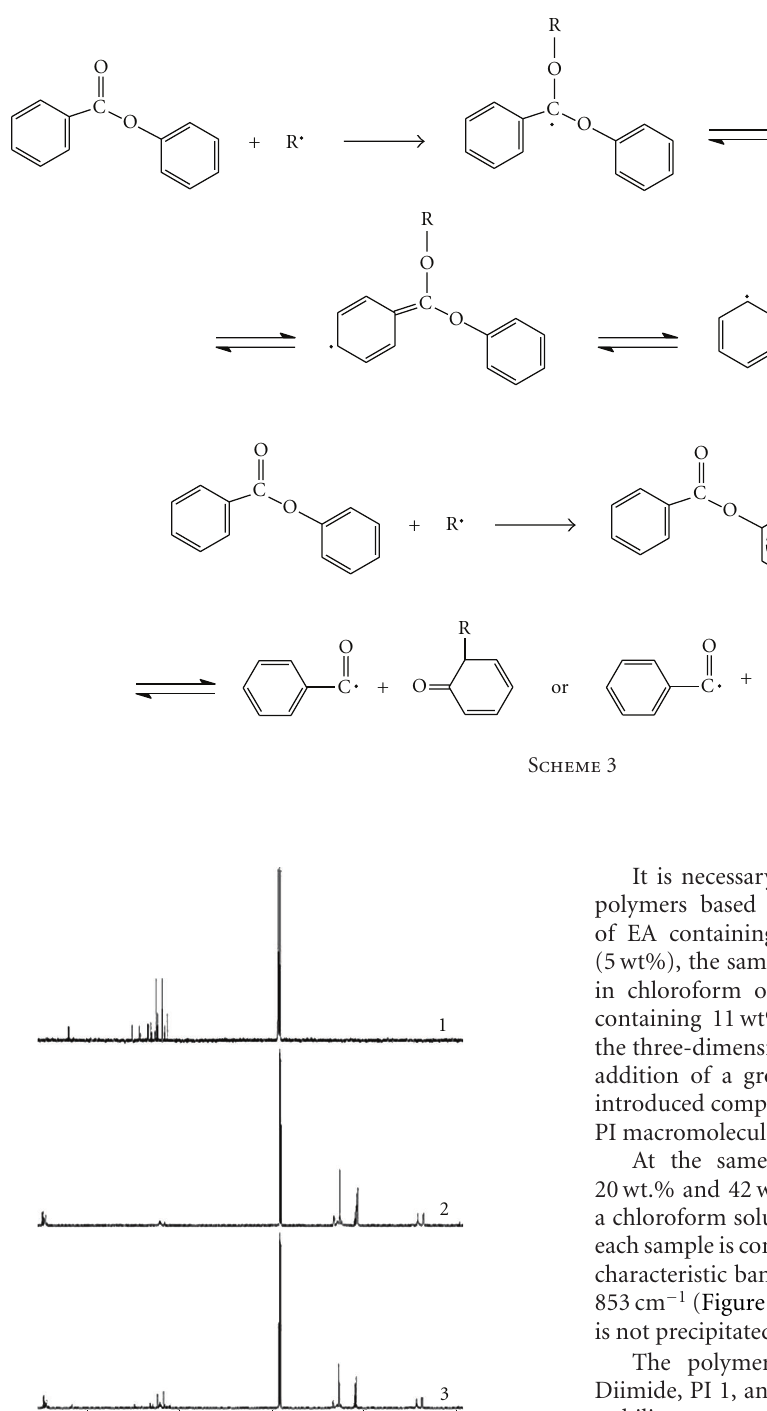
interaction of Diimide with the radicals, formed during the photoinitiated polymerization of MMA, is also indicated by kinetic